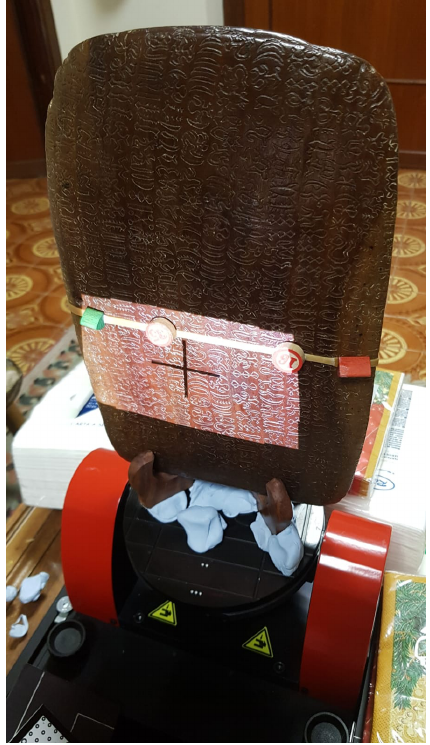
Figure 3: Markers; the illuminated area corresponds to the